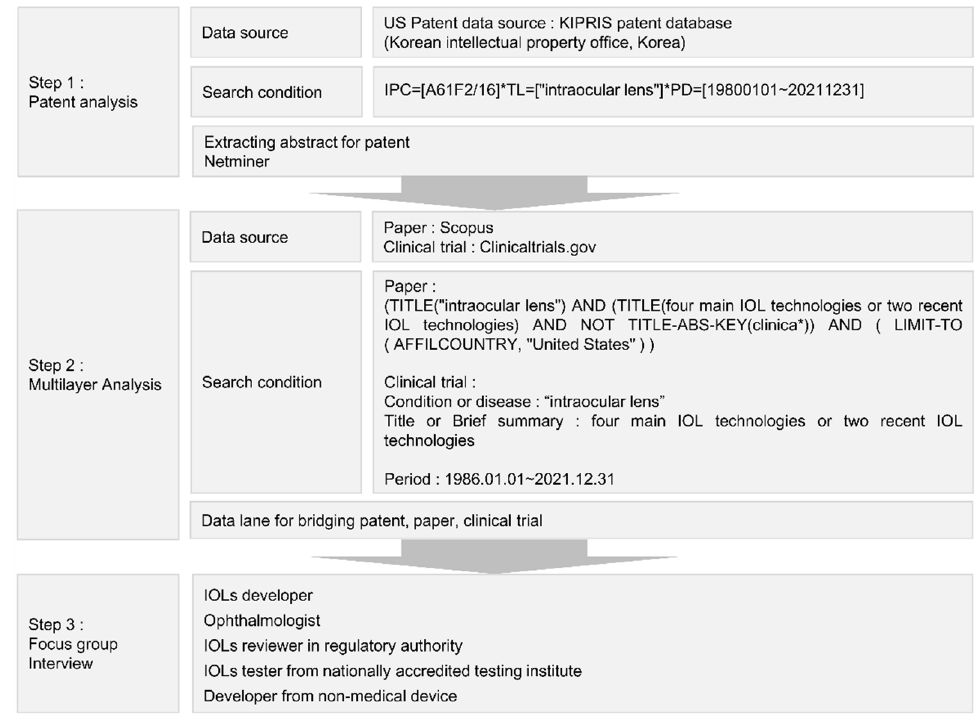
Figure 1. Methodological framework.